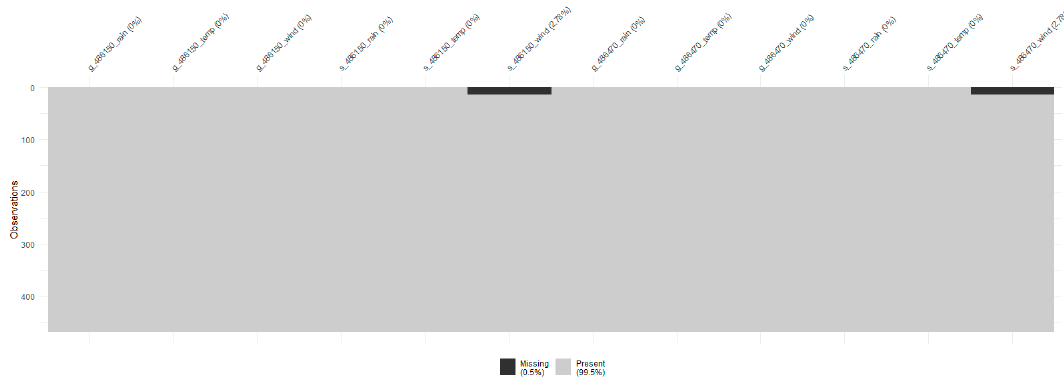
Figure A2. Missing data.